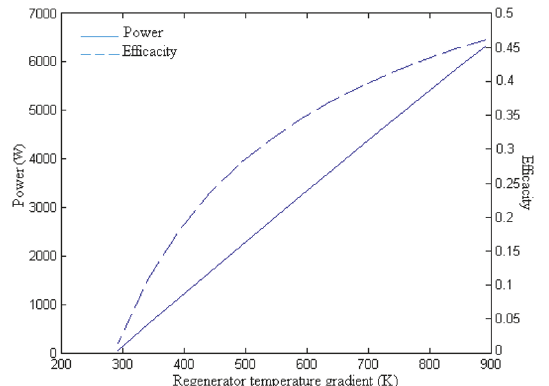
Figure 14: Power and efficiency variation with regenerator the temperature